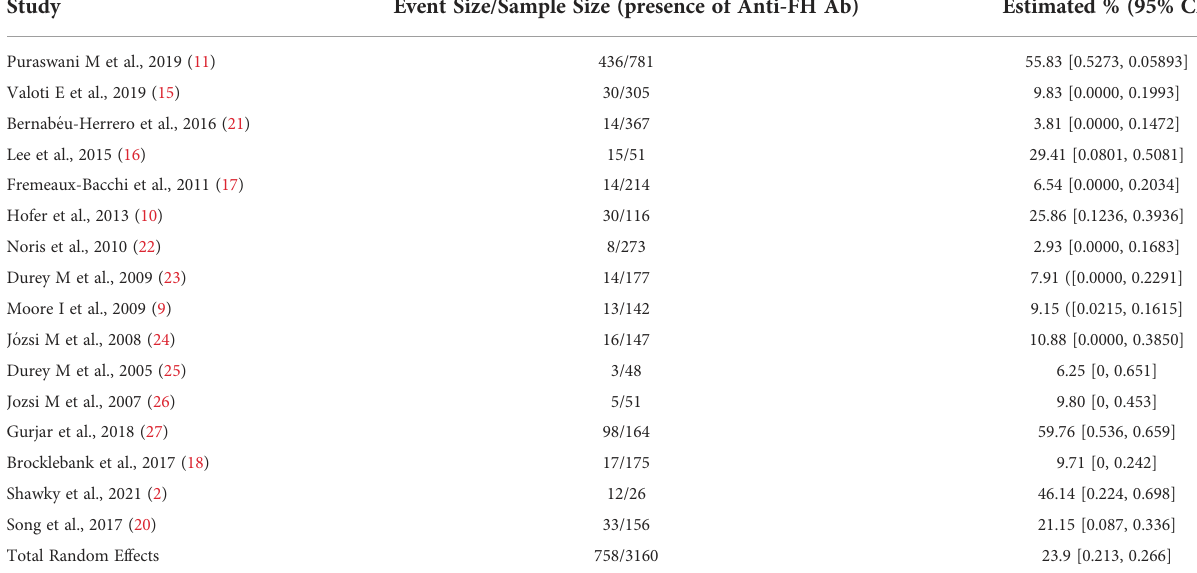
TABLE 2 A summary of anti-FH antibodies in aHUS patients over 16 studies with 95% con fi dence intervals.